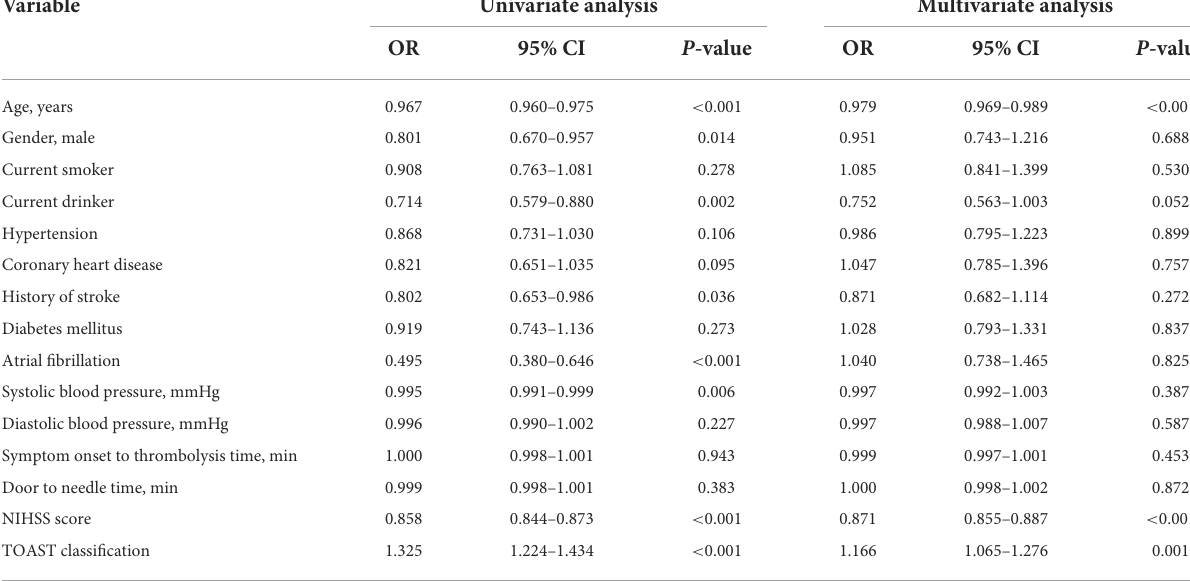
TABLE 4 Univariate and multivariate logistic regression analysis to predict excellent functional outcome (OR and 95% CI). Variable